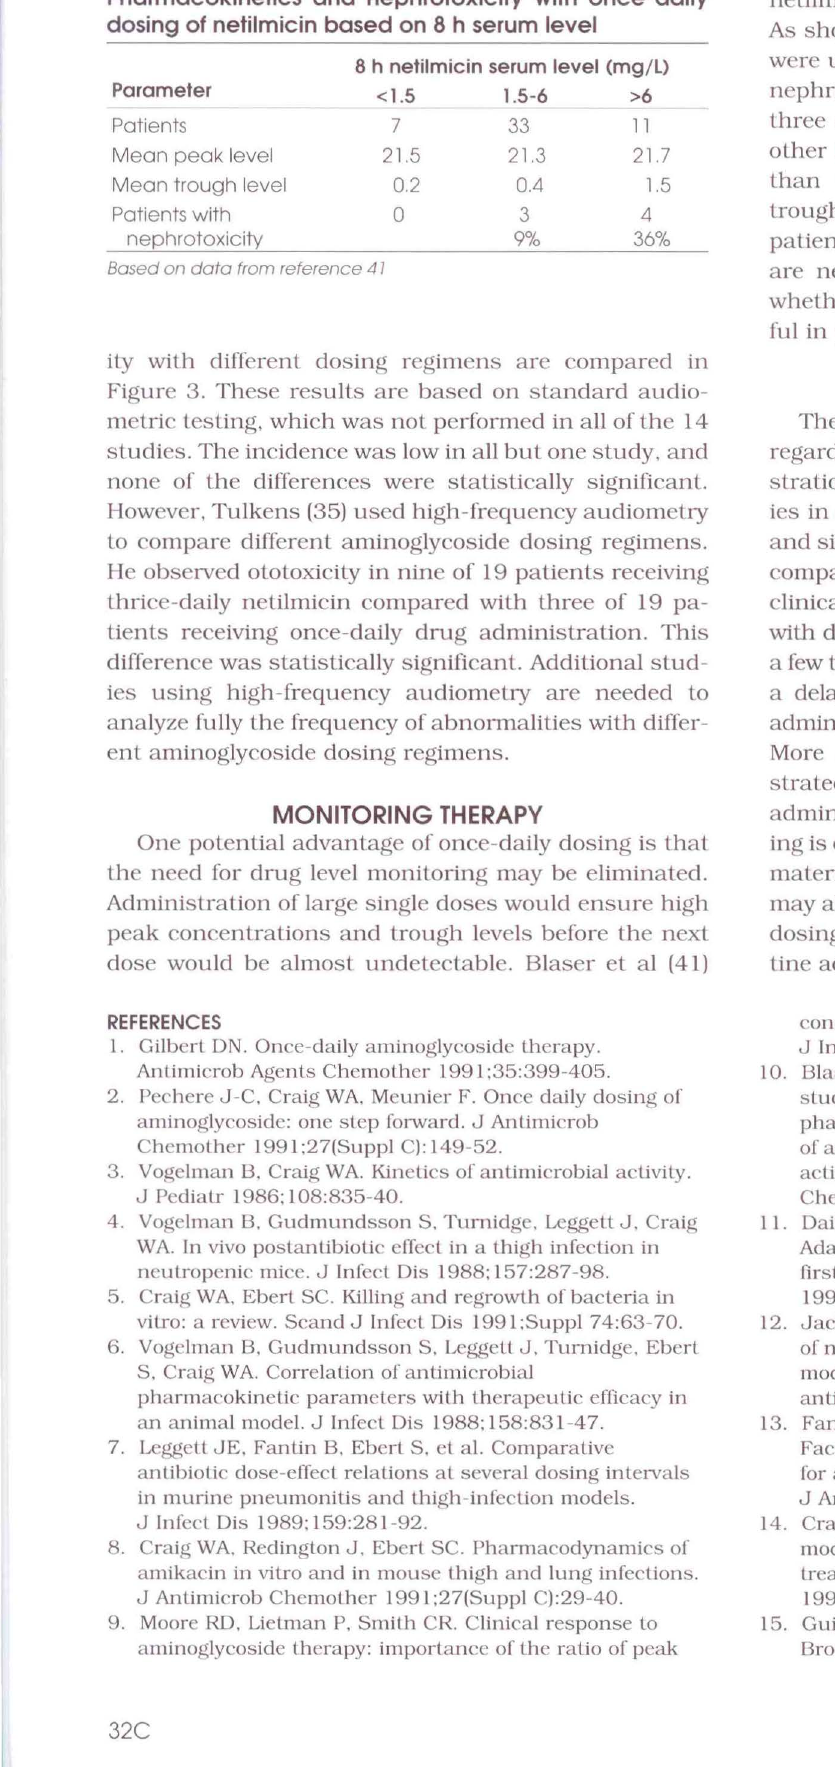
Pharmacokinetics and nephrotoxicity with once-daily dosing of netilmicin based on 8 h serum